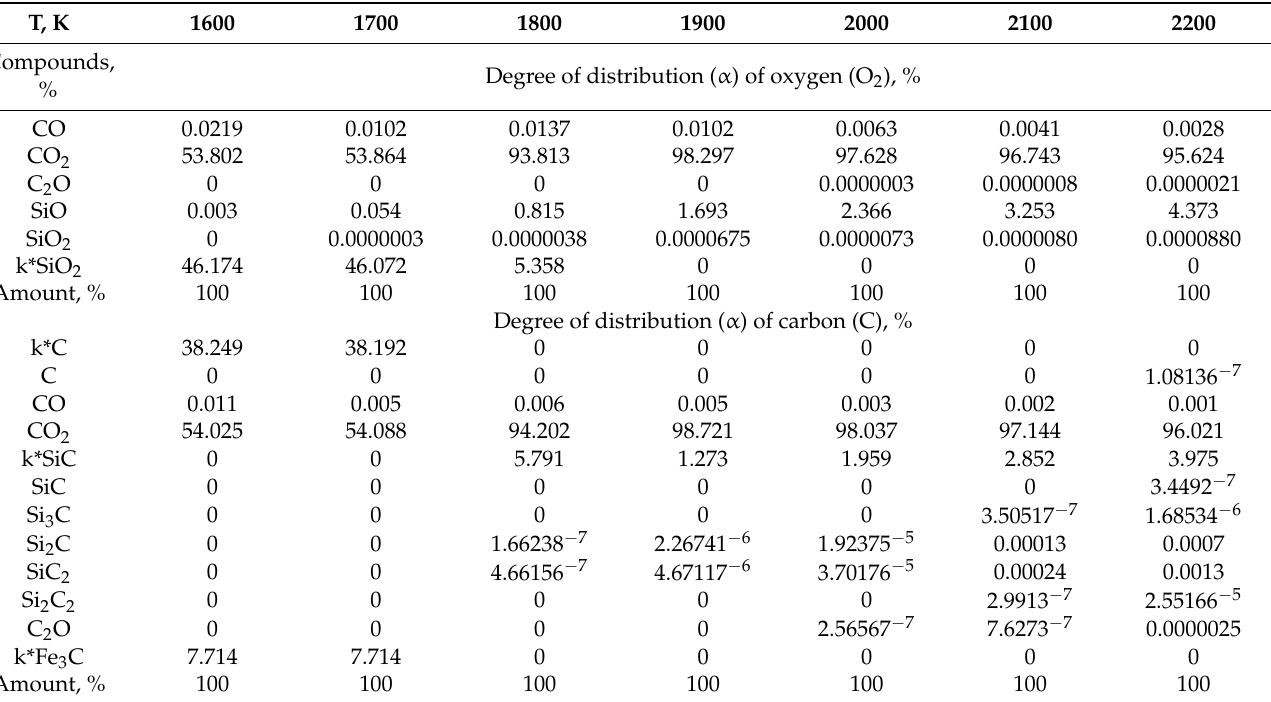
Table 2. Influence of temperature (T) on the degree of distribution of ( α ) oxygen (O 2 ) and carbon (C) in the ZnO · SiO 2 -FeO · Fe 2 O 3 -C